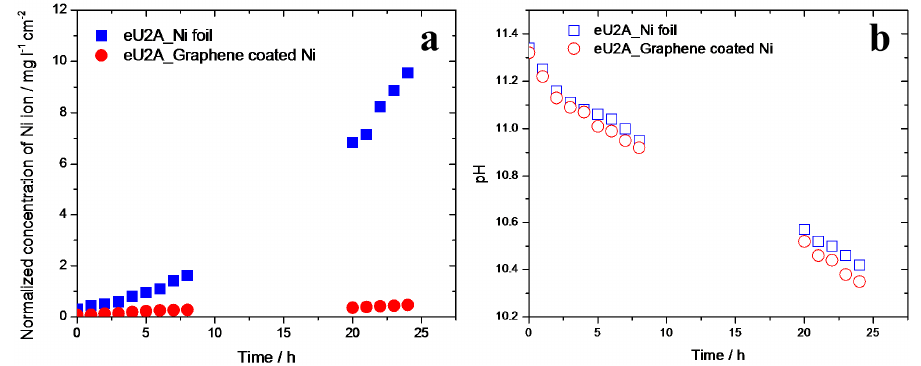
Figure 9. ( a ) Normalized concentration of Ni ion (per cm 2 of the working electrode) in the electrolyte during 24 h eU2A experiments using Ni foil and graphene ‐ coated Ni working electrodes. ( b ) pH change during eU2A reactions using Ni foil and graphene ‐ coated Ni. The pH value of the electrolyte is time dependent; pH value is reduced in the eU2A process due to the transformation of K 2 CO 3 to KHCO 3 by the generated CO 2 from eU2A reaction. With the help of graphene coating, the normalized Ni loss per surface area was reduced by ~20 times.